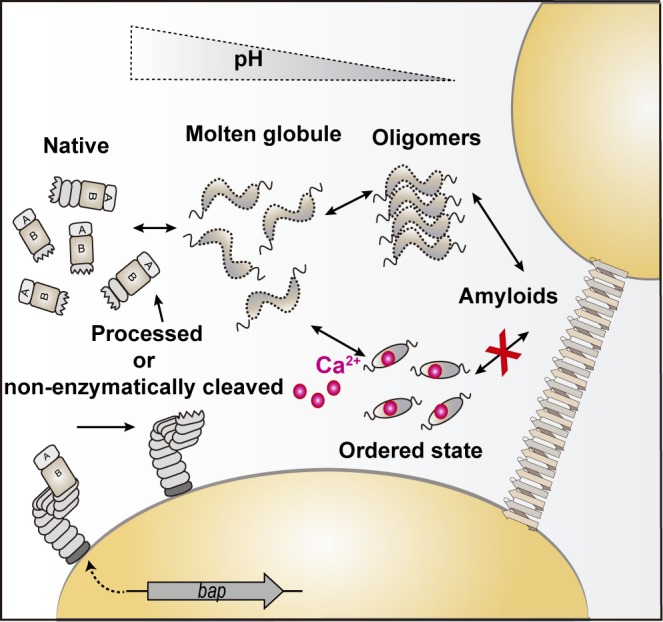
Summary illustrating the effect of pH and calcium in Bap-mediated multicellular behavior.Once located on the bacterial surface, Bap is processed or non-enzymatically cleaved liberating fragments containing the N-terminal domain of the protein that adopt a molten globule-like state. In acidic environments, Bap N-terminal fragments start to self-assemble and ultimately form amyloid fibers that mediate cell-to-cell contacts and biofilm formation through the interaction with the bacterial cell surface by a still unknown mechanism. On the contrary, and in spite of medium acidification, the presence of calcium divalent cations bound to Bap stabilizes the protein. Consequently, Bap is unable to self-assemble into amyloid fibers and does not mediate biofilm formation.